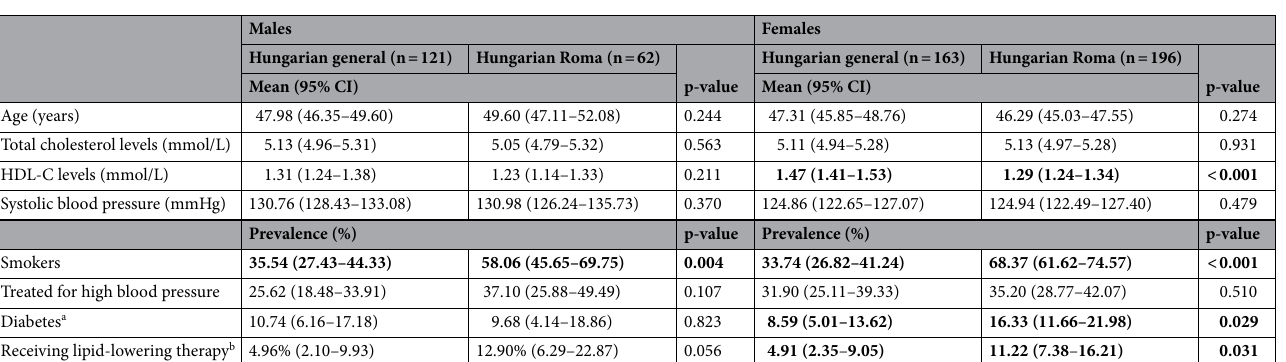
Table 2. Characteristics of 30–64-year-old study populations involved in the Framingham Risk Score for hard coronary heart disease (FRS CHD ) and Framingham Risk Score for cardiovascular disease (FRS CVD ) calculations by ethnicity and sex. Significant differences in mean or prevalence rates are highlighted in bold. a Used only in the FRS CVD calculation. b Not used for risk calculation in any risk assessment